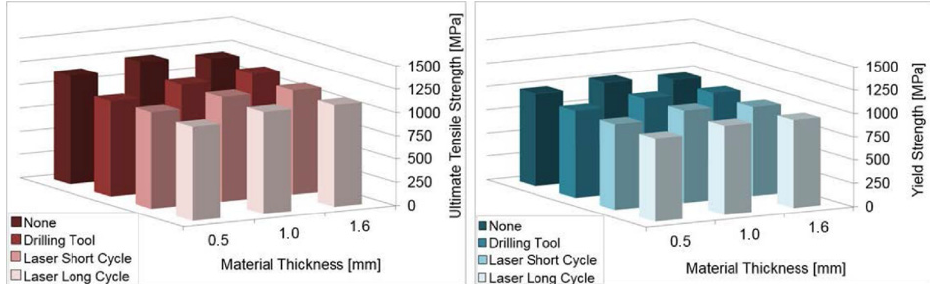
Figure 21. Comparison of results of uniaxial tensile testing at elevated temperature.